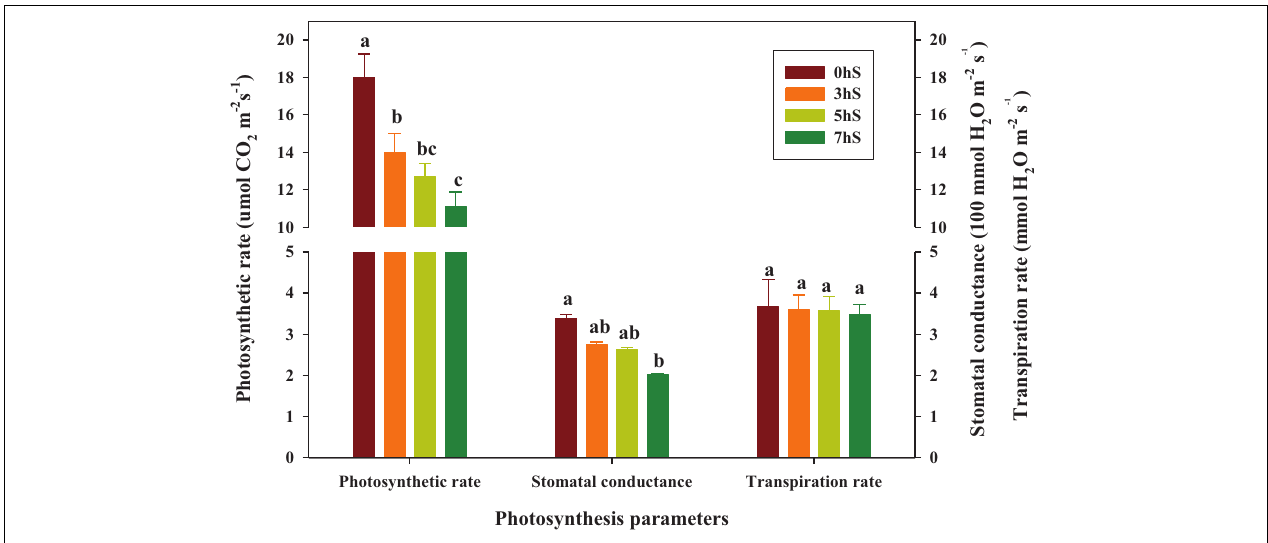
FIGURE 3 | Photosynthesis parameters of strawberry ( Fragaria × ananassa ) leaves grown under various light intensity conditions in a smart greenhouse. Vertical bars represent standard deviations. Different letters above the bars indicate significant differences among treatments (Duncan’s multiple range test, p < 0.05, n = 9). 0 hS, non-shading treatment (control); 3 hS, three hours of shading until 10:00; 5 hS, five hours of shading until 12:00; 7 hS, seven hours of shading until 14:00.